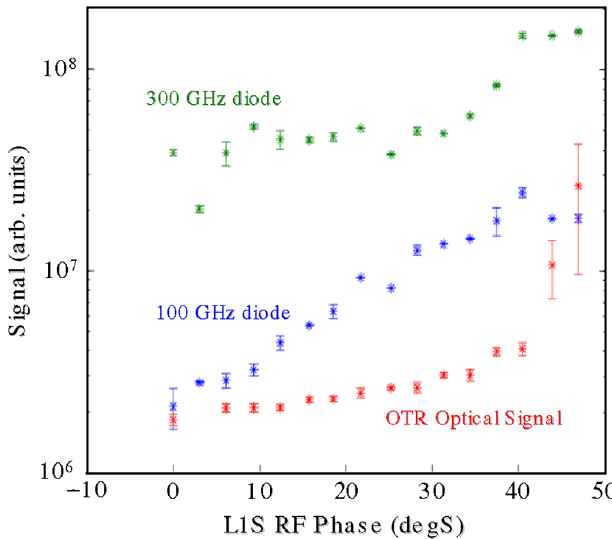
FIG. 41. (Color) The signals of the BL 12 microwave detectors at 100 GHz (blue) and 300 GHz (green), and the image- integrated OTR optical signal (red), as seen by a digital camera, are plotted (log scale) as functions of the L1S rf phase relative to the accelerating crest (at phase (cid:6) 0 ). The increase in the OTR signal suggests the onset of